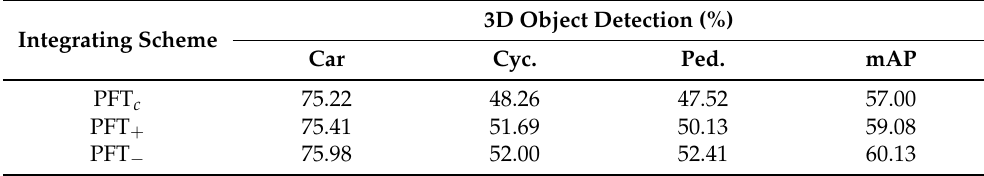
Table 6. Comparison of fusion structure in PFT to